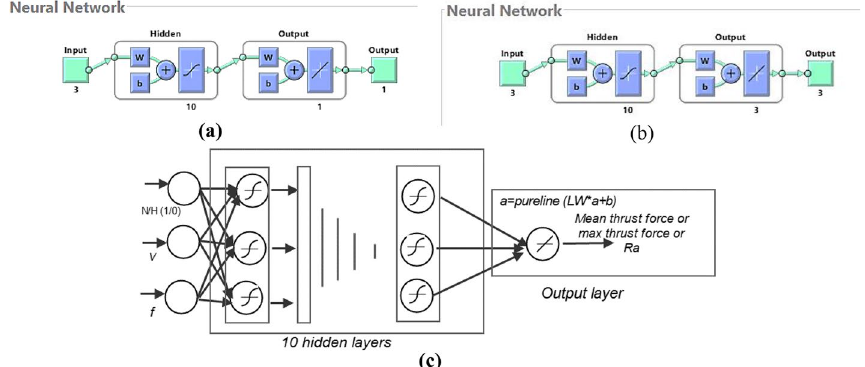
Fig. 3 The neural network architecture for a one output model and b three outputs models and c detailed used of neural network